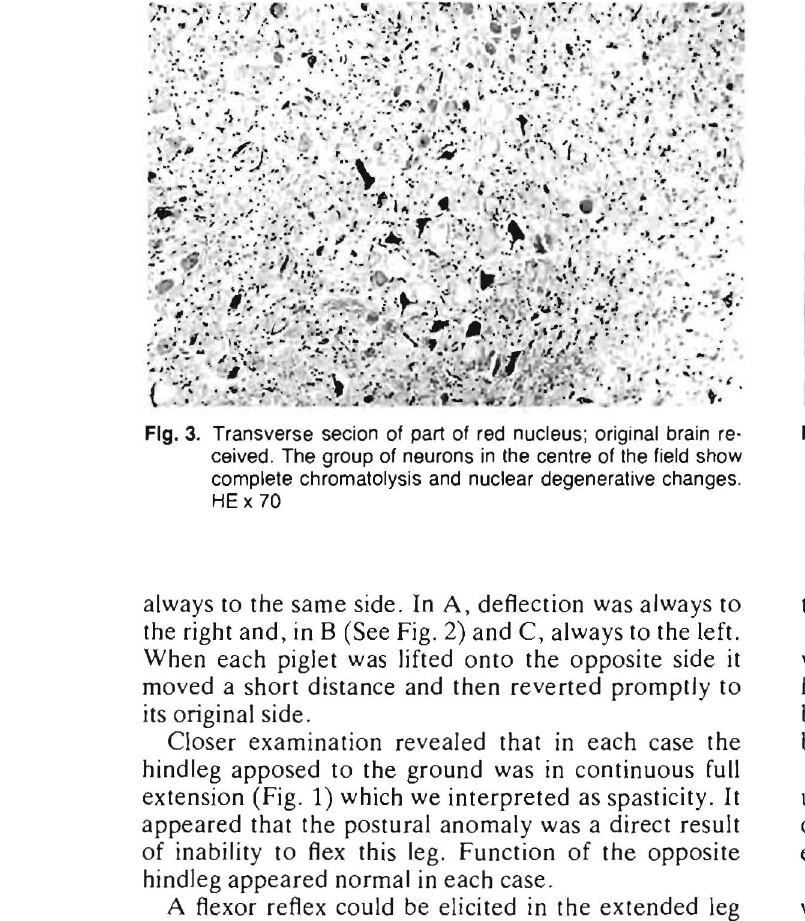
Fig. 5. Neuron showing central chromatolysis and nuclear margina tion. Lumbar cord. piglet B. HE x 1 000.